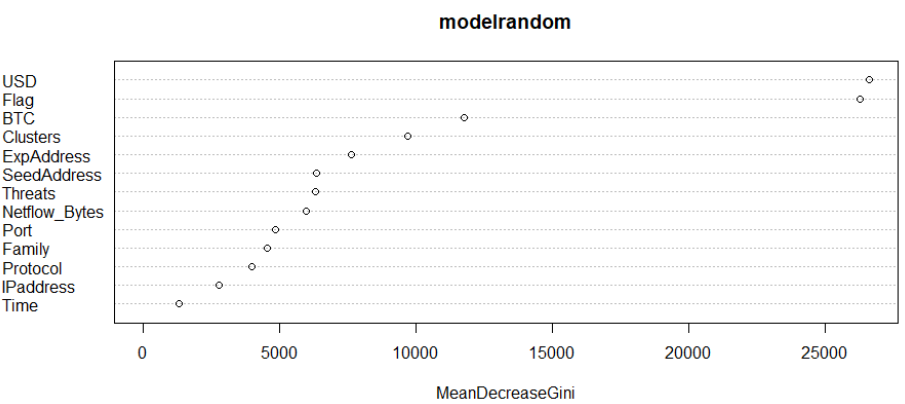
Figure 31. The Mean Decreased value with only 13 attributes of the 14 which are in the UGRan- some